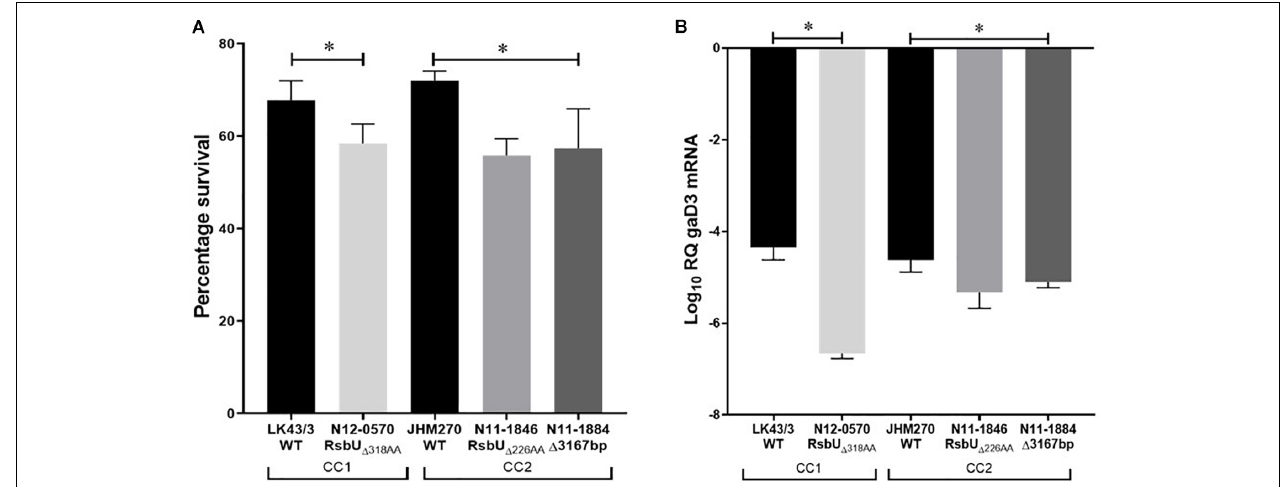
FIGURE 10 | Phenotypic evaluation of high nisin sensitivity L. monocytogenes strains with natural sigB operon mutations. (A) Survival of Triton X-100 exposure and (B) gadD3 mRNA quantification high nisin sensitivity sigB operon mutant strains (N11-1846, N11-1884, and N12-0570) compared with control strains (JHM270 and LK43/3) of the same MLST CC with an intact sigB operon. ∗ P > 0.05 significant differences that were identified using one-way ANOVA and Tukey post hoc (groups with more than two strains) pairwise comparison of the strains.